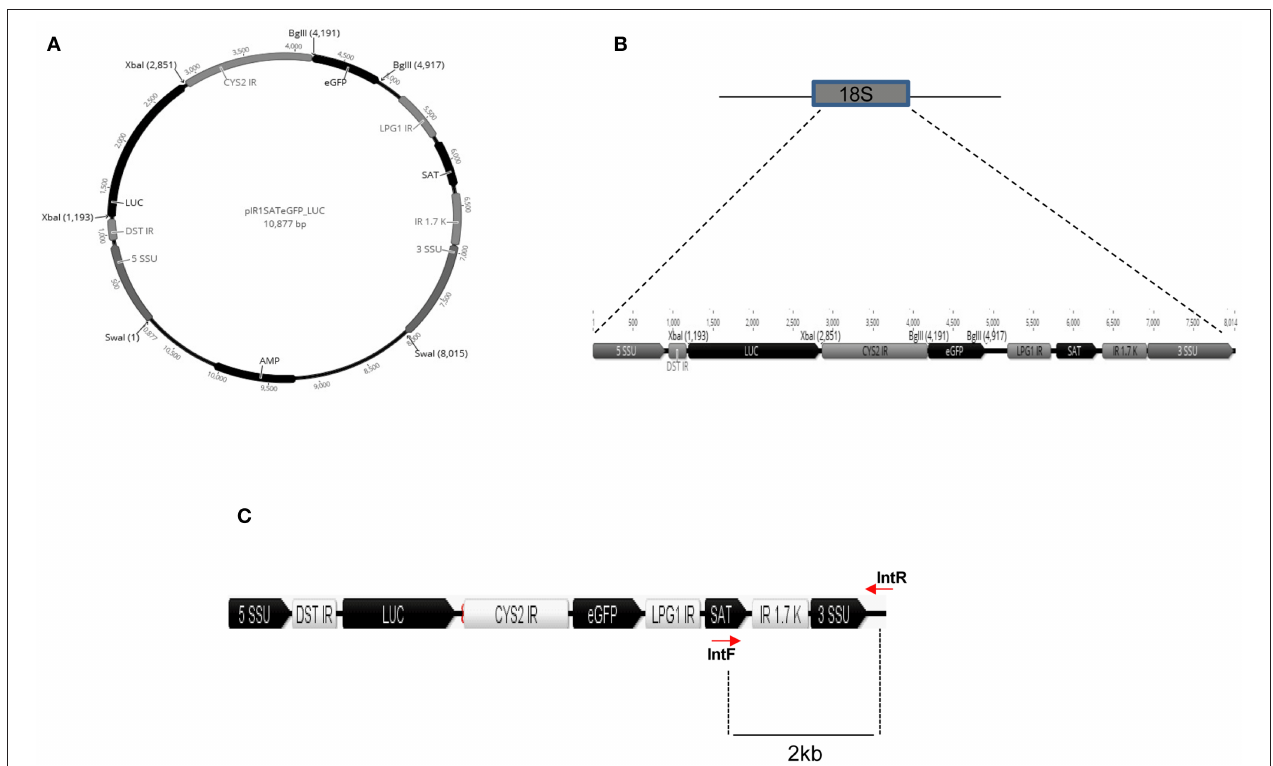
FIGURE 1 | In silico construct of pIRSATeGFP_LUC. (A) Luciferase and eGFP genes cloned between the XbaI and BglII restriction sites, respectively. (B) Schematic representation of the SSU integration locus and the cassette for integration with eGFP and LUC ORF. (C) Schematic representation of the linear cassette for integration in the SSU rDNA locus. SSU, small subunit, DST IR, intergenic region of the DST gene, LUC, Luciferase, CYS2 IR, intergenic region of cysteine protease 2 gene, eGFP, enhanced GFP, LPG1R, intergenic region of the LPG1 gene, SAT, nourseothricine resistance gene, IR 1.7K, intergenic region of dihydrofolate reductase-thymidylate symthase locus. Position of the primers and size of amplified fragments are indicated by